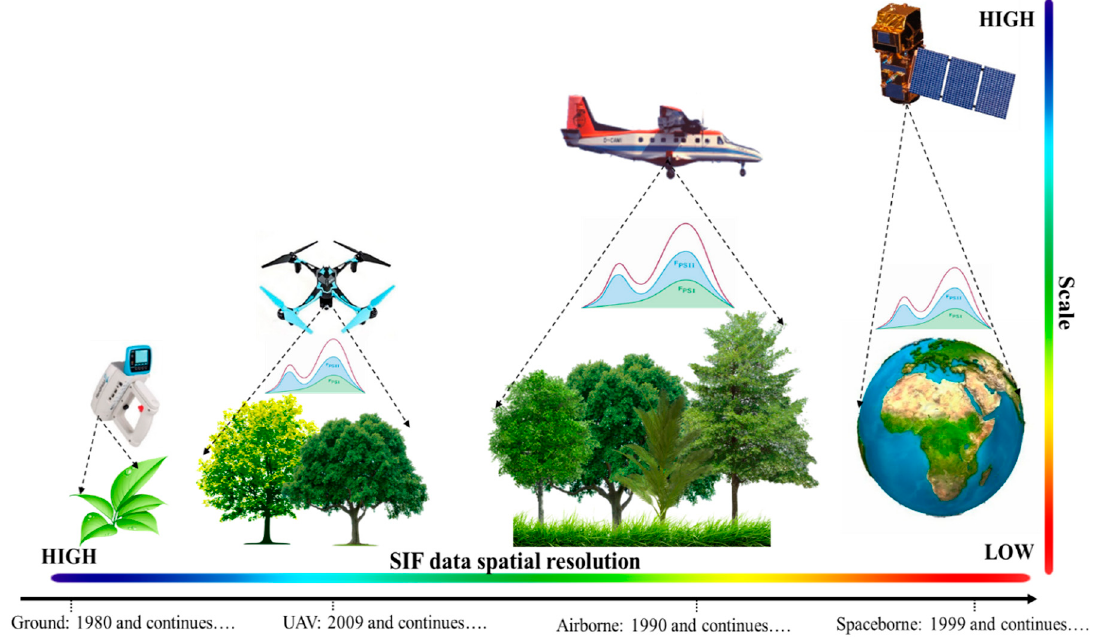
Figure 1. Different platforms used for top-of-canopy SIF measurments applied over time at different scales and spatial resolutions. scales and spatial